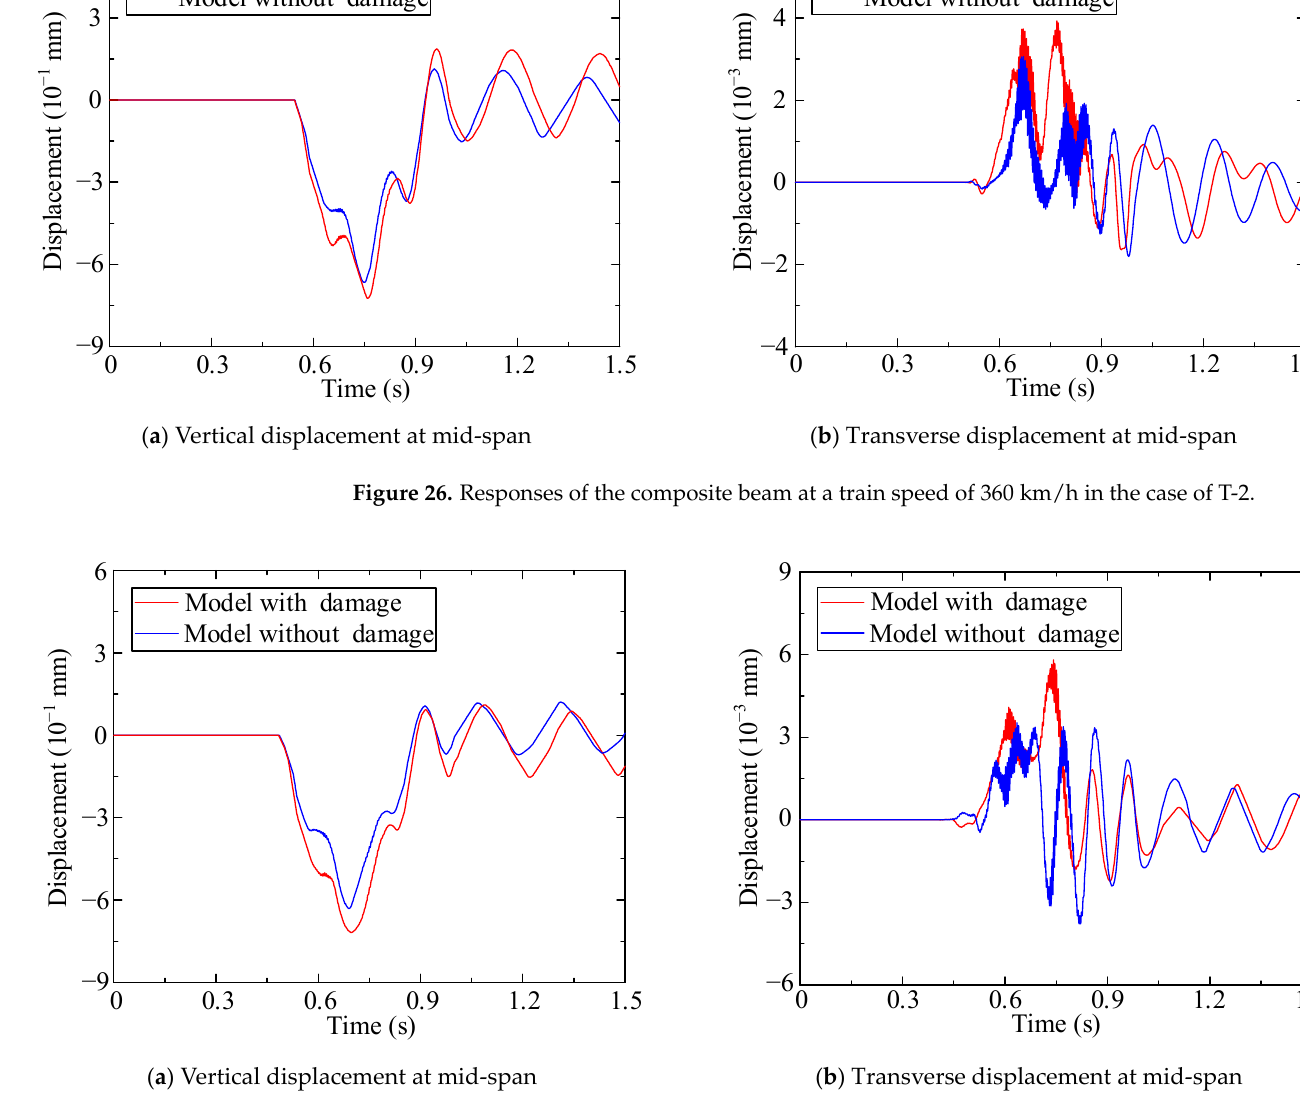
Figure 27. Responses of the composite beam at a train speed of 330 km/h in the case of T-2. Table 8. Comparison of maximum displacement at mid-span of composite